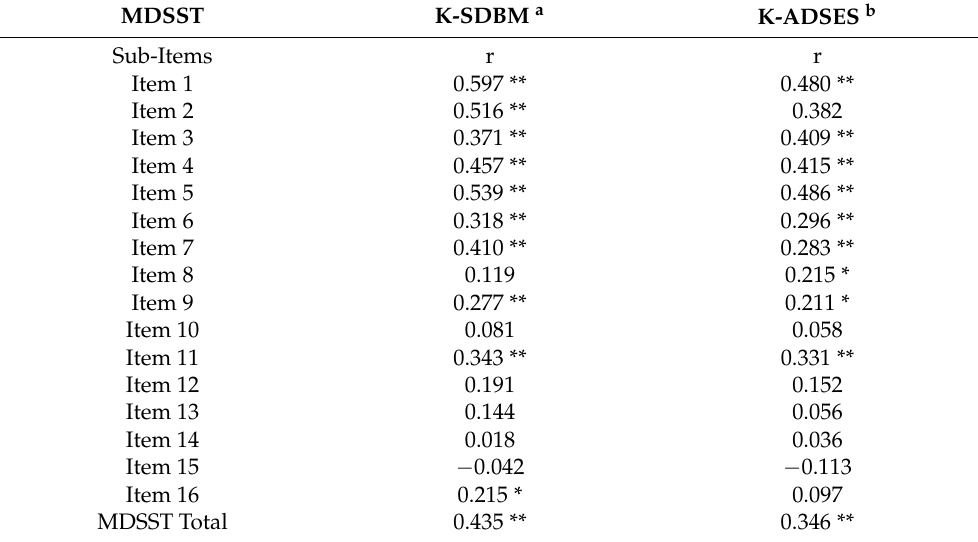
Table 4. Correlations between MDSST, K-ADSES and K-SDBM ( n = 102).